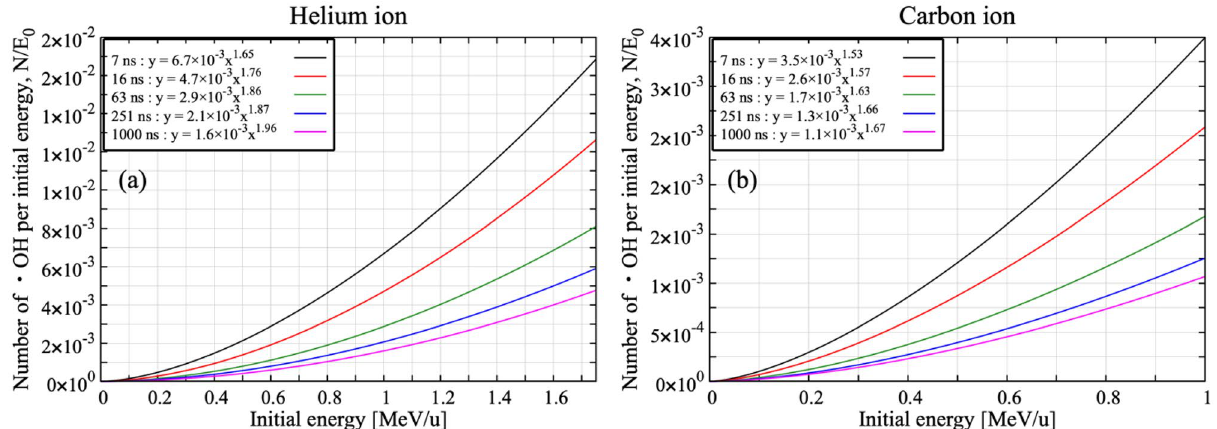
Figure 4. Number of · OH produced per initial energy as a function of the initial energies of He ( a ) and C ions ( b ) 7, 16, 63, 251 and 1000 ns after irradiation.